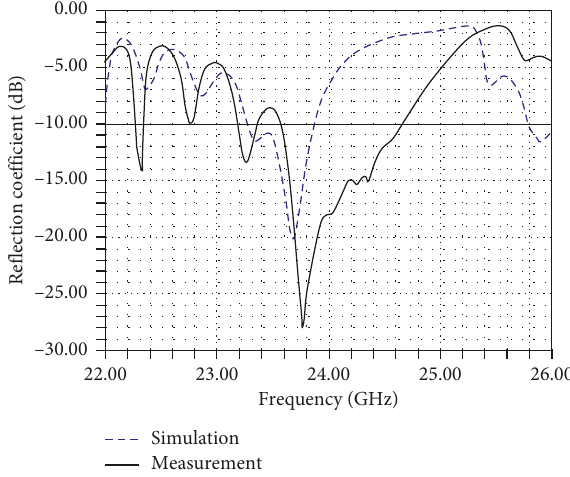
Figure 7: Reflection coefficient of the novel SWAA. Table 2: Summary of the novel SWAA experimental